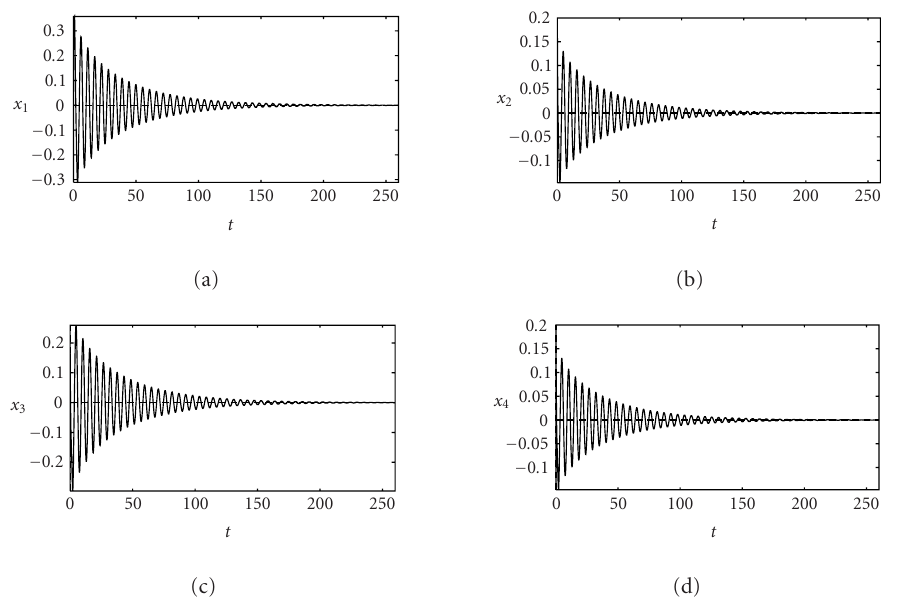
Figure 5.1. The trajectories graphs of system (5.14) with τ 1 = 1 . 2, τ 2 = 0 . 8, and initial data x 1 ( t ) = x 2 ( t ) = x 3 ( t ) = x 4 ( t ) = 0 . 3, t ∈ [ − 1 . 2,0].